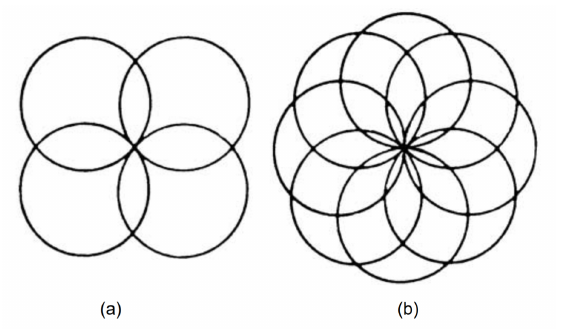
Figure 1. The lobe positions of ( a ) lobe-on-receive-only, and ( b ) conical-scan-receive-only antenna systems [6].